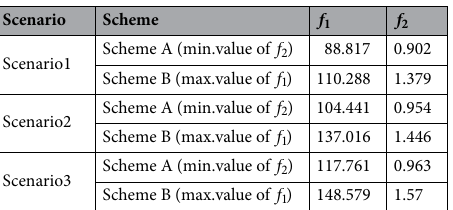
Table 5. The maximum and minimum values of the objective function for the three